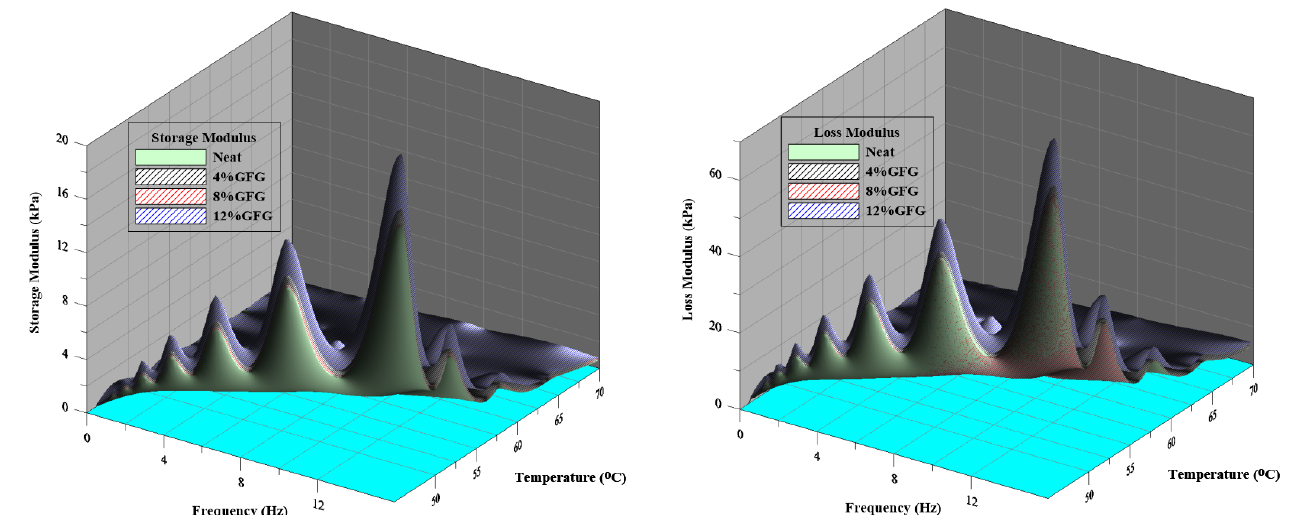
Figure 6. Temperatures and frequencies effects on the G (cid:48) and G (cid:48)(cid:48) of